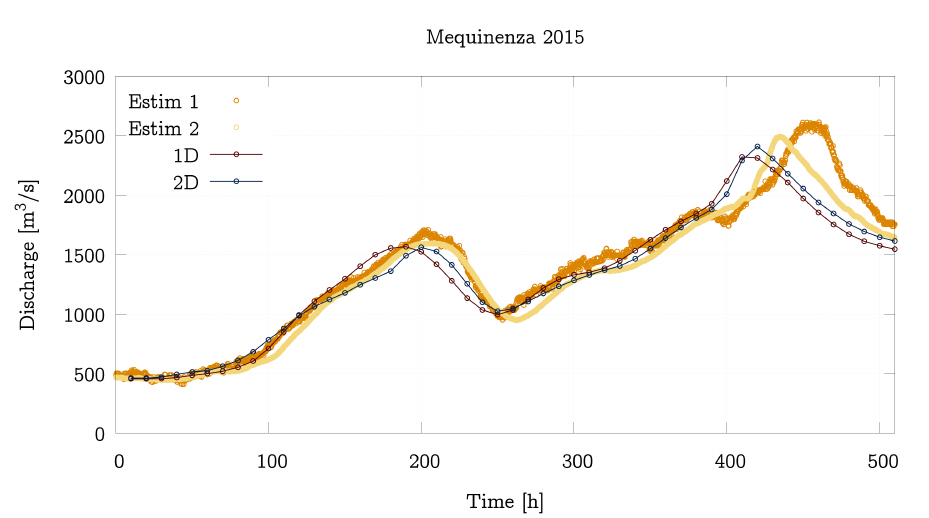
Figure 7. Discharge temporal evolution comparison between 1D model, 2D model and observa- tion at Gelsa (A263) gauging station ( upper ) and comparison between models and estimations at Mequinenza dam (E003) ( lower ) for 2015 event.